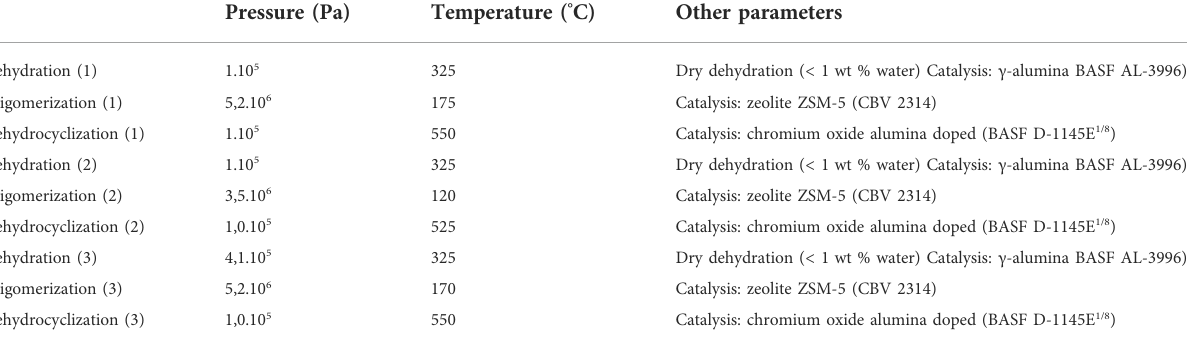
TABLE 1 Examples of pressure conditions, temperatures and other parameters for the GIFT ® process steps (adapted from Peters et al.,